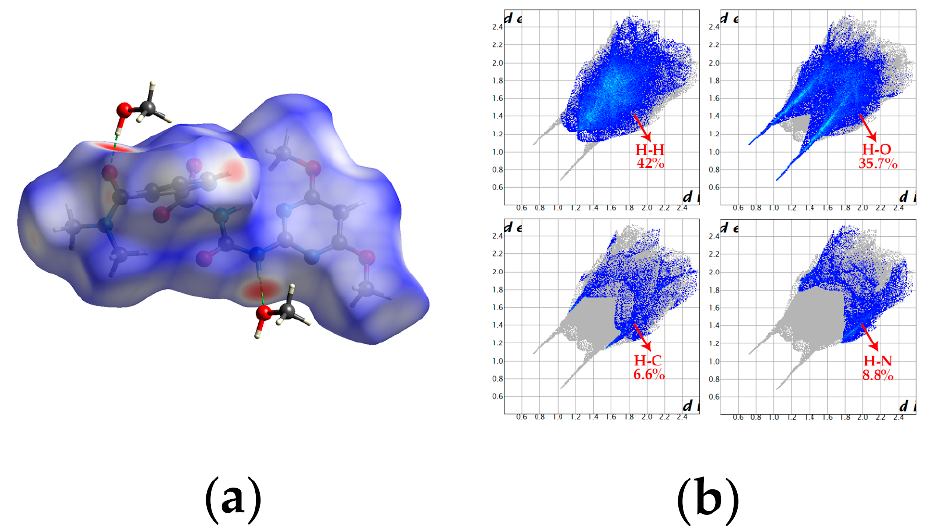
Figure 8. ( a ) Hirshfeld surface of the NS molecule in NS-MeOH. ( b ) 2D-fingerprint plots combined with the relative contributions of dominant interactions of the NS molecule in NS-MeOH.